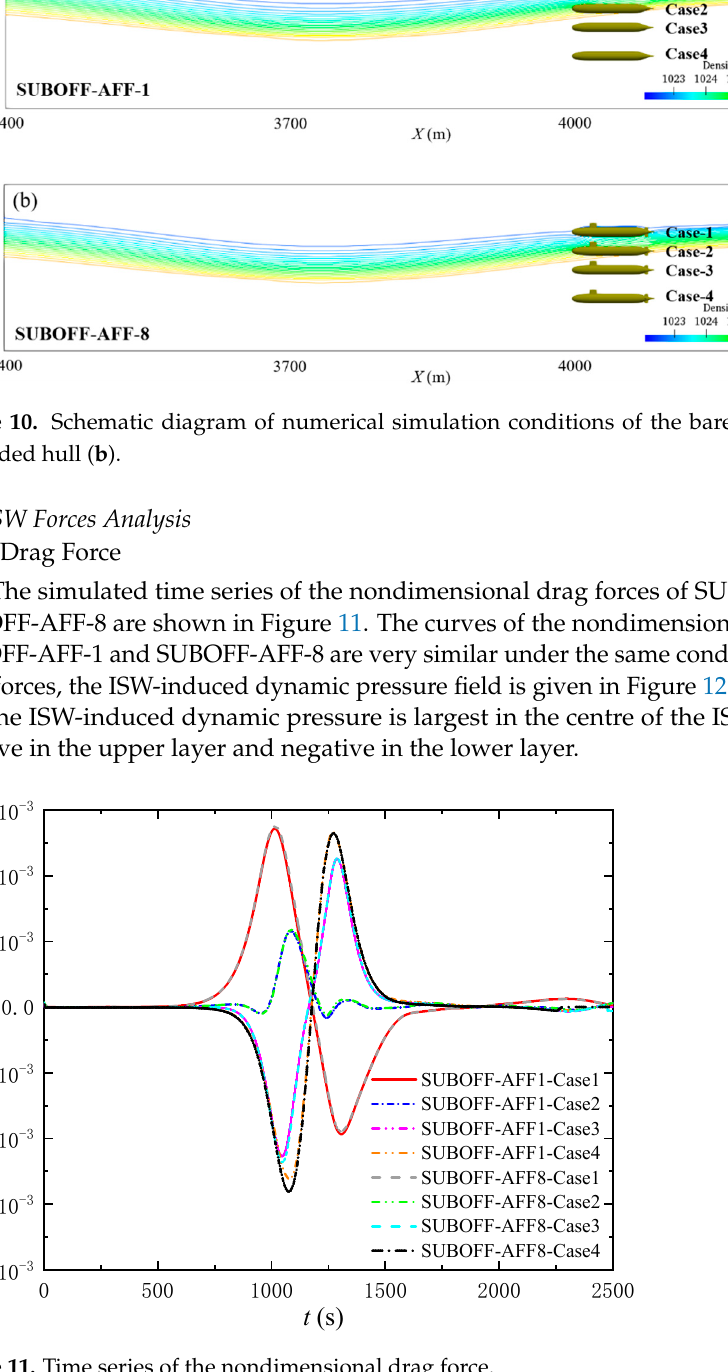
Figure 11. Time series of the nondimensional drag force.